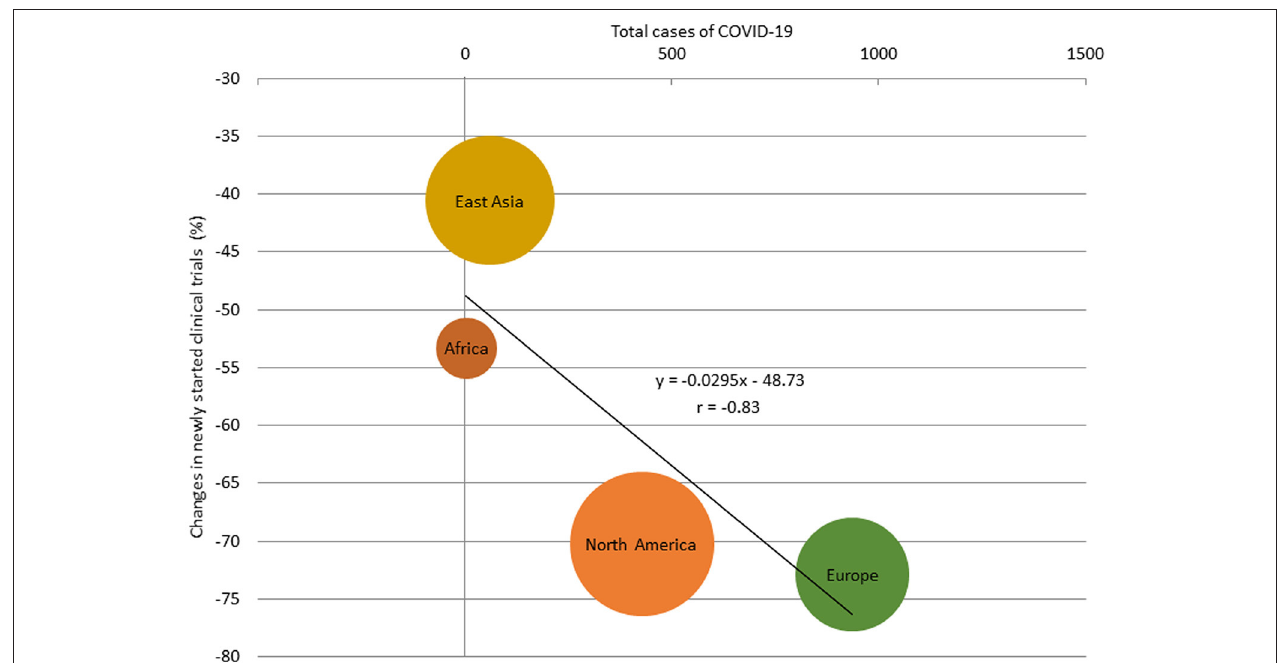
FIGURE 2 | Relationship between total cases of COVID-19 and percentage change of the number of newly started clinical trials for diseases other than COVID-19 in regions with more than 30 studies, April 2020. The size of the bubbles reflected the number of